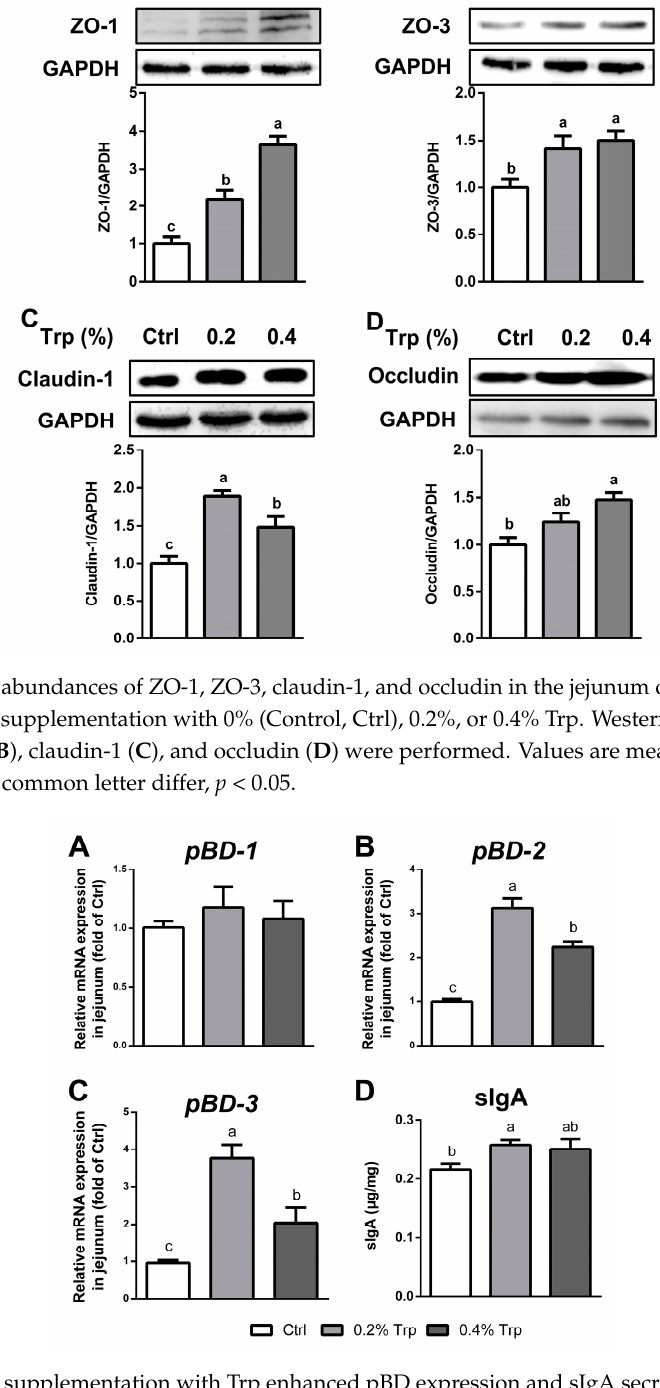
Figure 2. Dietary supplementation with Trp enhanced pBD expression and sIgA secretion in the small intestine of weaned piglets. ( A – C ) The mRNA levels of pBD-1, pBD-2, and pBD-3 in the mucosa of the jejunum. n = 6; and ( D ) the expression of sIgA in the mucosa of the jejunum. Values are means ± SEM, n = 6. Means without a common letter differ, p < 0.05. Ctrl, the control group (%